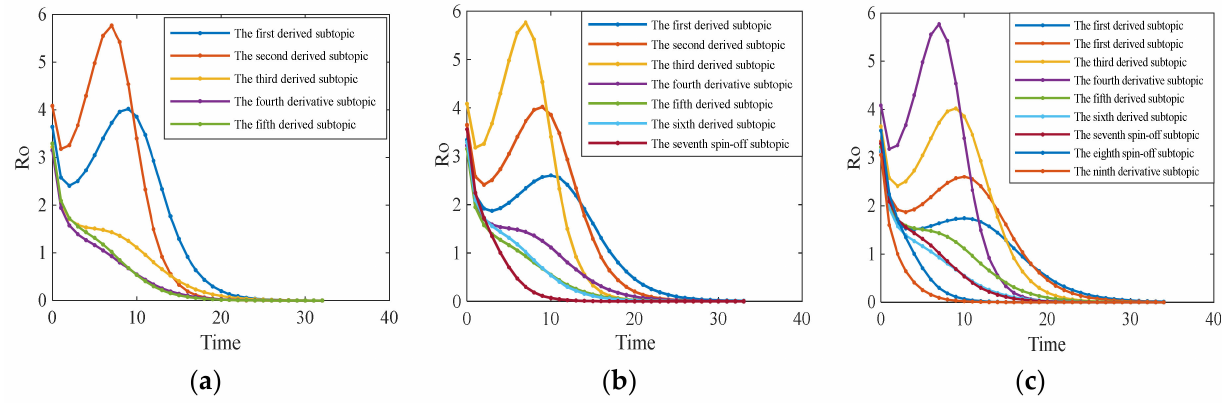
Figure 10. Changes of subtopics’ R 0 values under different information alienation settings. ( a ) ρ = 0.75. ( b ) ρ = 0.85. ( c ) ρ =